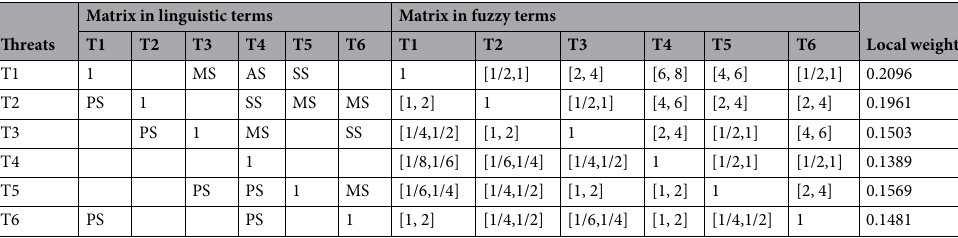
Table 7. Evaluation criteria of the Threats. (C.R. =